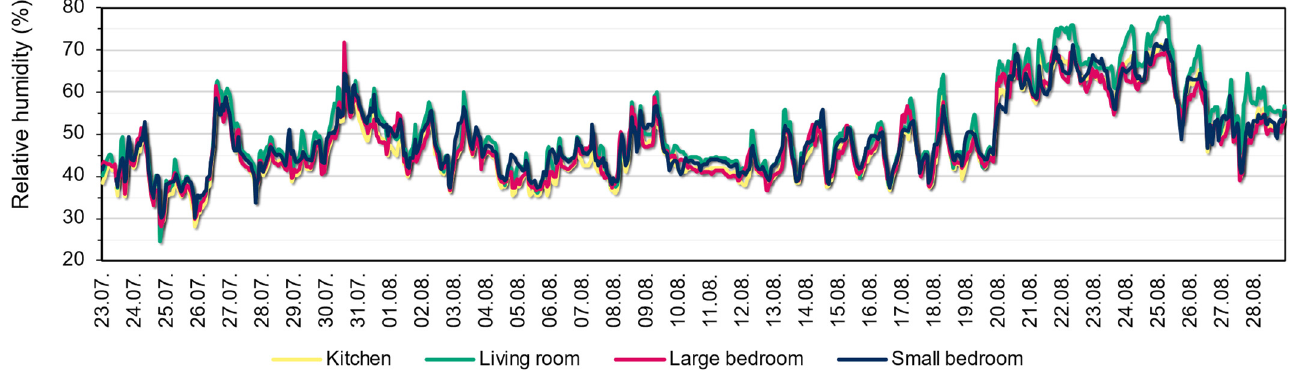
Figure 11. Measured relative humidity values within the apartment.